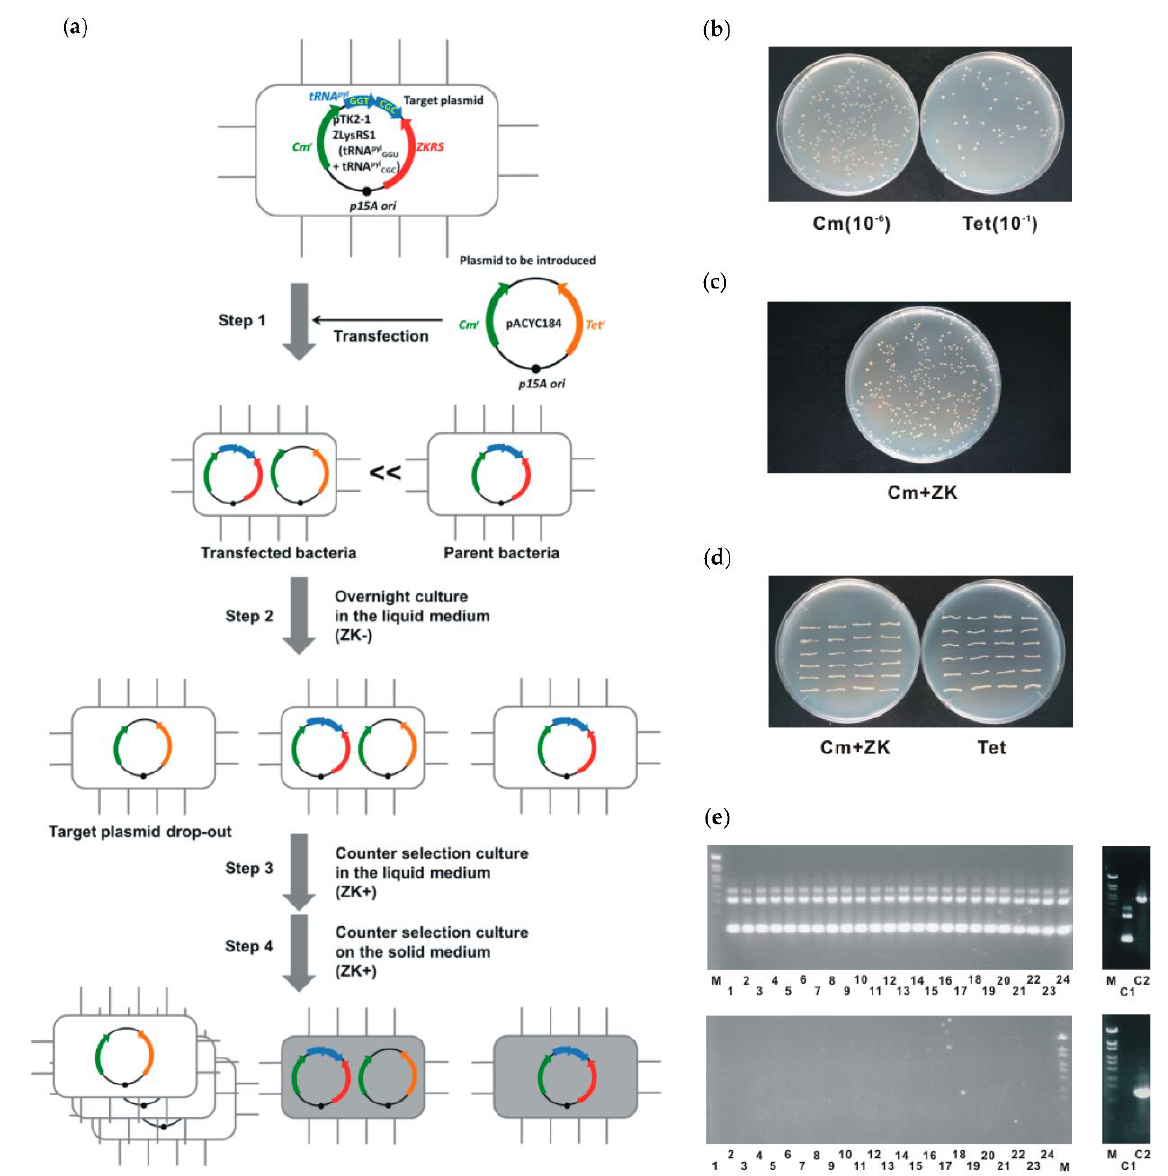
Figure 2. Plasmid exchange. ( a ) Schematic diagram of procedure. For detailed experimental conditions, see Materials and Methods. ( b ) Transfection of substitute plasmid. From bacterial suspension immediately after transfection in Step 1, bacteria carrying substitute plasmid were detected using tetracycline resistance. ( c ) Isolation of bacteria in which target plasmid was lost and only substitute plasmid was maintained. In Steps 3 and 4, bacteria were inoculated onto solid medium containing 3 mM ZK to eliminate those with target plasmid. Since medium also contains chloramphenicol, only bacteria that carried substitute plasmid grew. ( d ) Confirmation of maintenance of the substitute plasmid. Twenty–four colonies picked up randomly in Step 4 were tested for sensitivity to tetracycline. All tested colonies were tetracycline–resistant, suggesting that they all carried the substitute plasmid. ( e ) Specific detection of target and substitute plasmid by PCR. For 24 colonies, substitute plasmid (top row) and target plasmid (bottom row) were detected by PCR using specific primer sets. Bacteria carrying substitute plasmid (C1) and target plasmid (C2) were used as controls. M, molecular mass marker ( λ /StyI